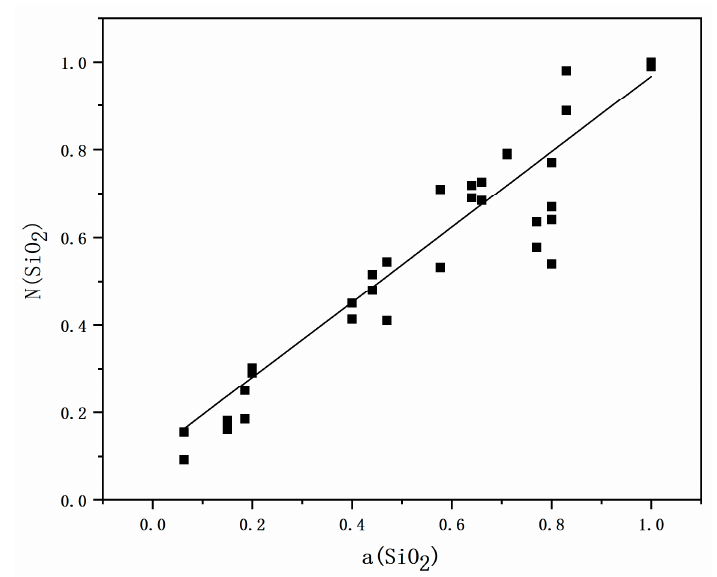
Figure 1. Verification of the CaO-Al 2 O 3 -SiO 2 -MgO quaternary slag system model by the comparison of model predicted values and values reported in the literature under the same thermodynamic conditions.